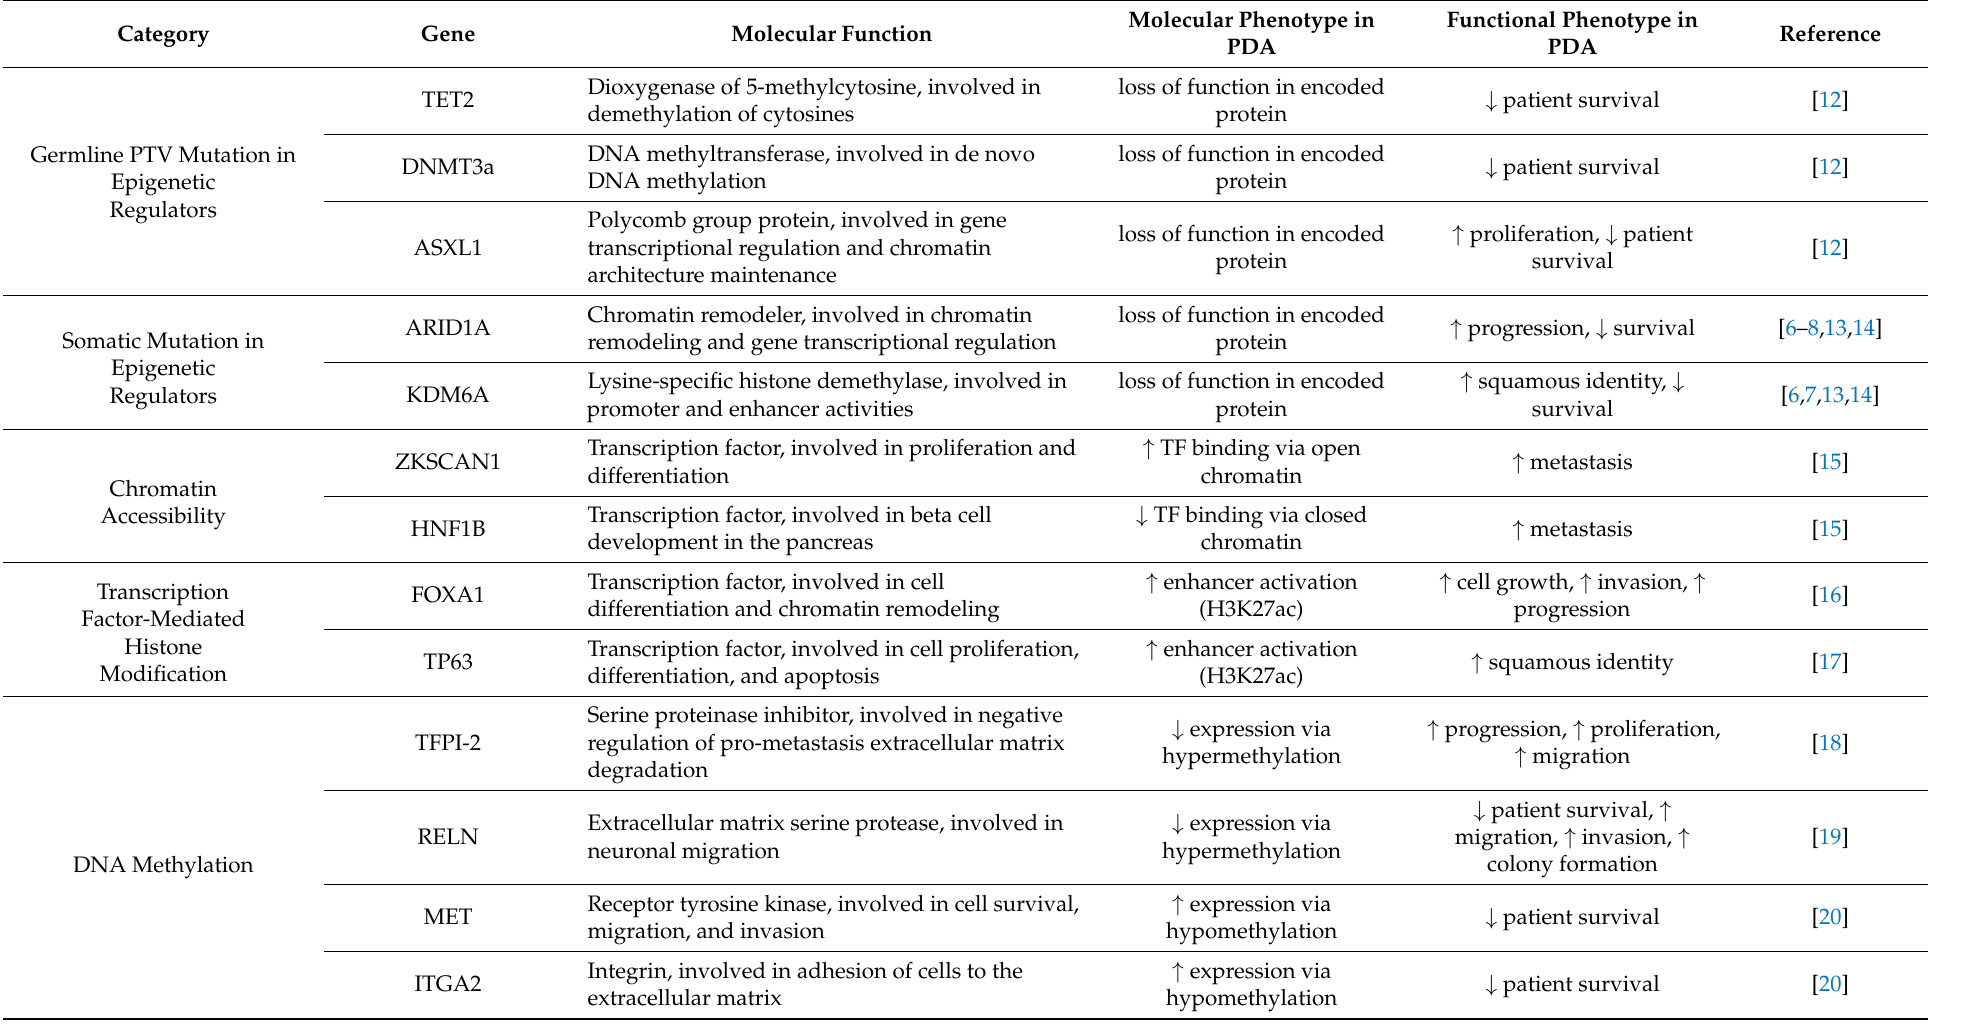
Table 1. Summary of reviewed genes that are related to epigenetic alterations during PDA progression and metastasis in the categories of germline PTV mutation, somatic mutation, chromatin accessibility and nucleosome remodeling, histone modification, and DNA methylation. ↓ denotes decrease and ↑ denotes